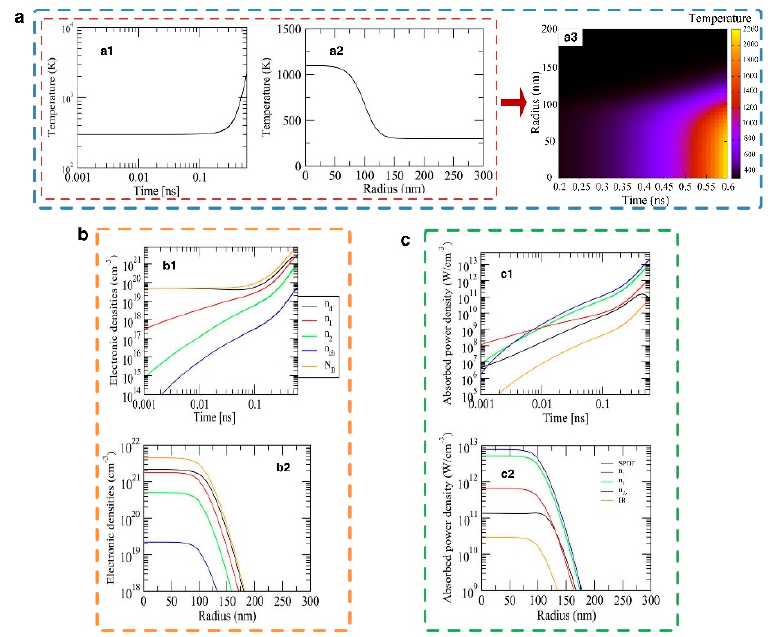
Figure 11. The temporal and spatial (T and S) evolution of the predicted lattice temperature, the electronic densities, and the absorbed power density of the precursor. ( a ) Lattice temperature with a1 temporal scale, a2 spatial scale, and a3 the physical quantities depend both on space and time; ( b ) Electronic densities with b1 temporal scale and b2 spatial scale; and ( c ) Absorbed power density with c1 temporal scale and c2 spatial scale. The position of precursor of a1 , b1 , and c1 is in the center, and the actuation duration of a2 , b2 , and c2 is 500 ps [77].